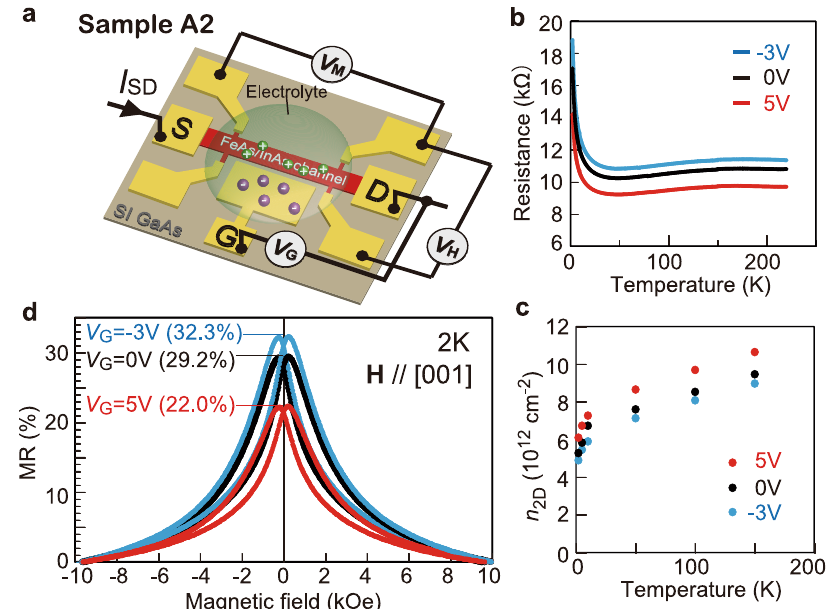
Fig. 4 Gate voltage control of the magnetoresistance (MR) in FeAs/InAs SLs. a Electrical double-layer transistor structure formed on sample A2 (see “ Method ” ). b Resistance and c sheet electron density ( n 2D ) in the FeAs/InAs SL structure at various temperatures under different gate voltages 5 V. d MR curves measured in the FeAs/InAs SL at 2 K with different gate voltages V G = – 3, 0, 5 V, under a magnetic fi eld applied perpendicular to the fi lm plane. These MR curves show clear hysteresis due to the ferromagnetism in sample A2. The values of MR ratio are given in the parentheses after the gate